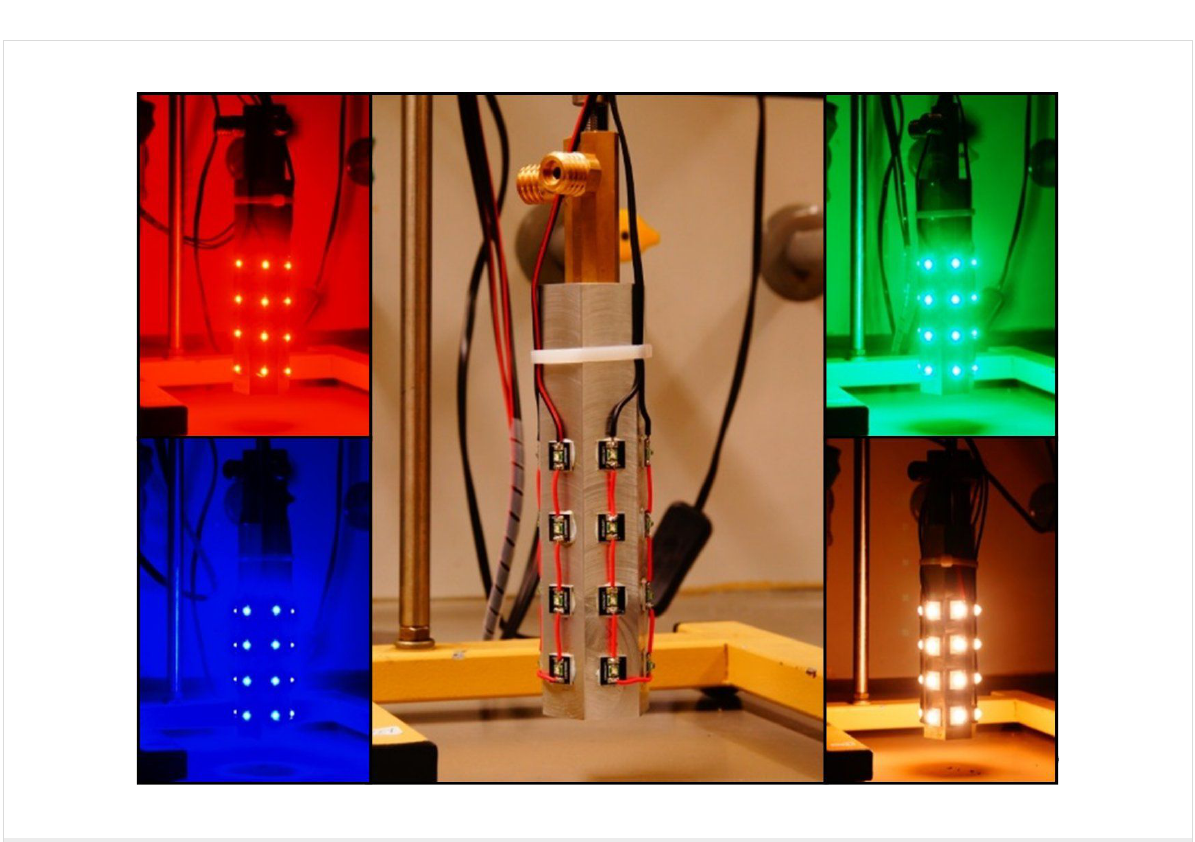
Figure 3: Red ( λ max = 633 nm), blue ( λ max = 448 nm), green ( λ max = 520 nm) and white ( λ max = 620 nm) LEDs mounted on a water cooled alumini- um cooling